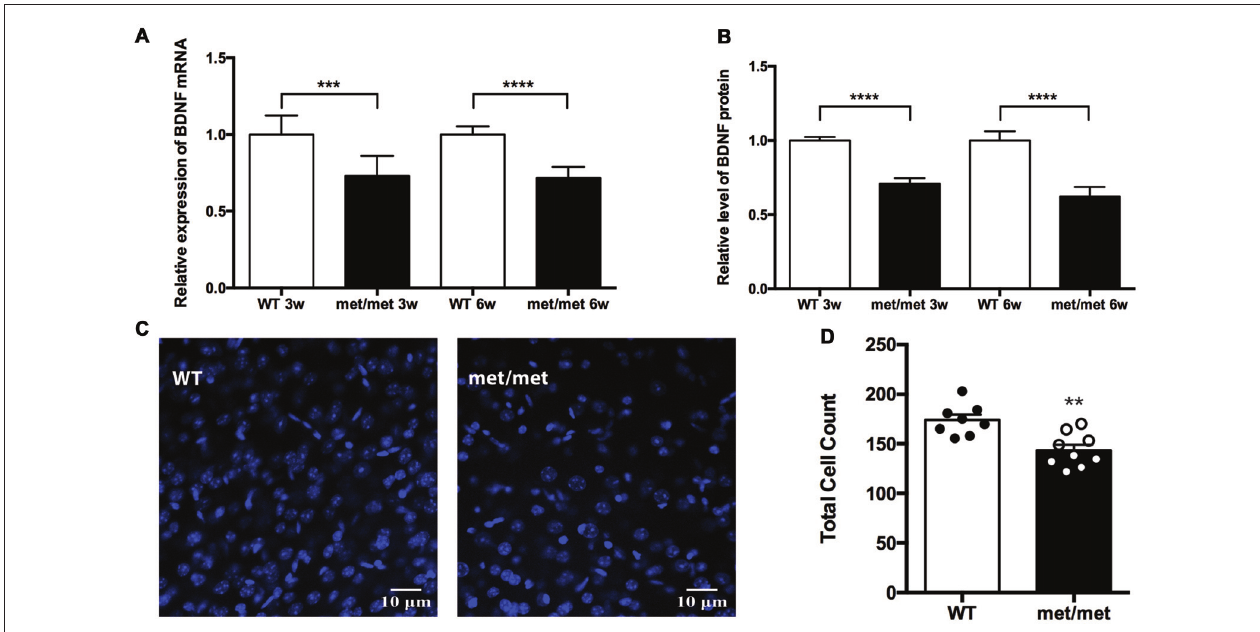
FIGURE 1 | Expression of brain-derived neurotrophic factor (BDNF) and total cell number were down-regulated in BDNF Met / Met mice. (A) Relative expression of BDNF mRNA by Quantigene assay (3w: WT: N = 8; BDNF Met / Met : N = 8; P < 0.001, 6w: WT: N = 8; BDNF Met / Met : N = 7; P < 0.0001). (B) Relative expression of BDNF protein by ELISA (3w: WT: N = 8; BDNF Met / Met : N = 8; P < 0.0001, 6w: WT: N = 8; BDNF Met / Met : N = 7; P < 0.0001). (C) Image of cells in the hippocampal CA1 region (6w). (D) Total cell count decreased in BDNF Met / Met mice ( N = 8 from three mice for WT; N = 9 from three mice for BDNF Met / Met ). ∗∗ P < 0.01; ∗∗∗ P < 0.001; ∗∗∗∗ P < 0.0001.